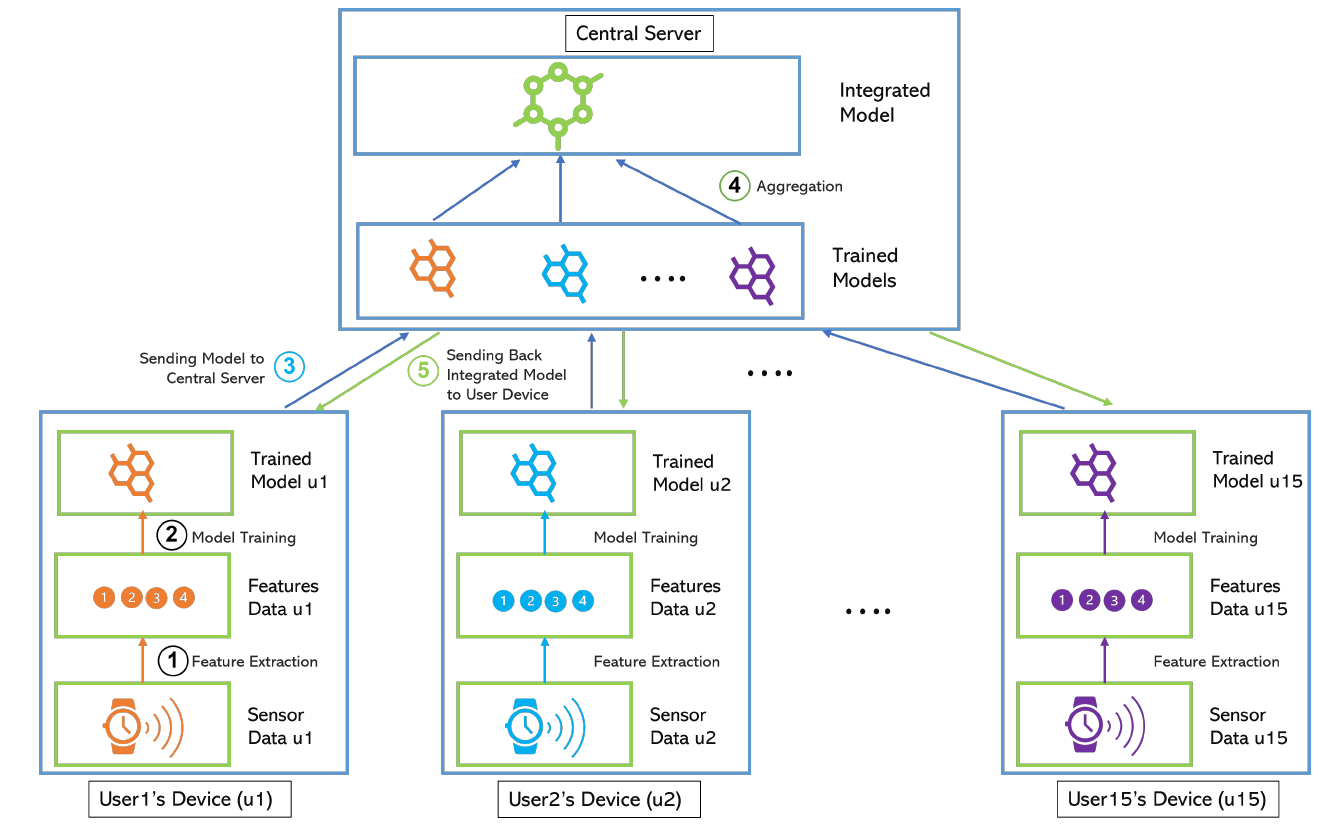
Figure 3. Federated Learning